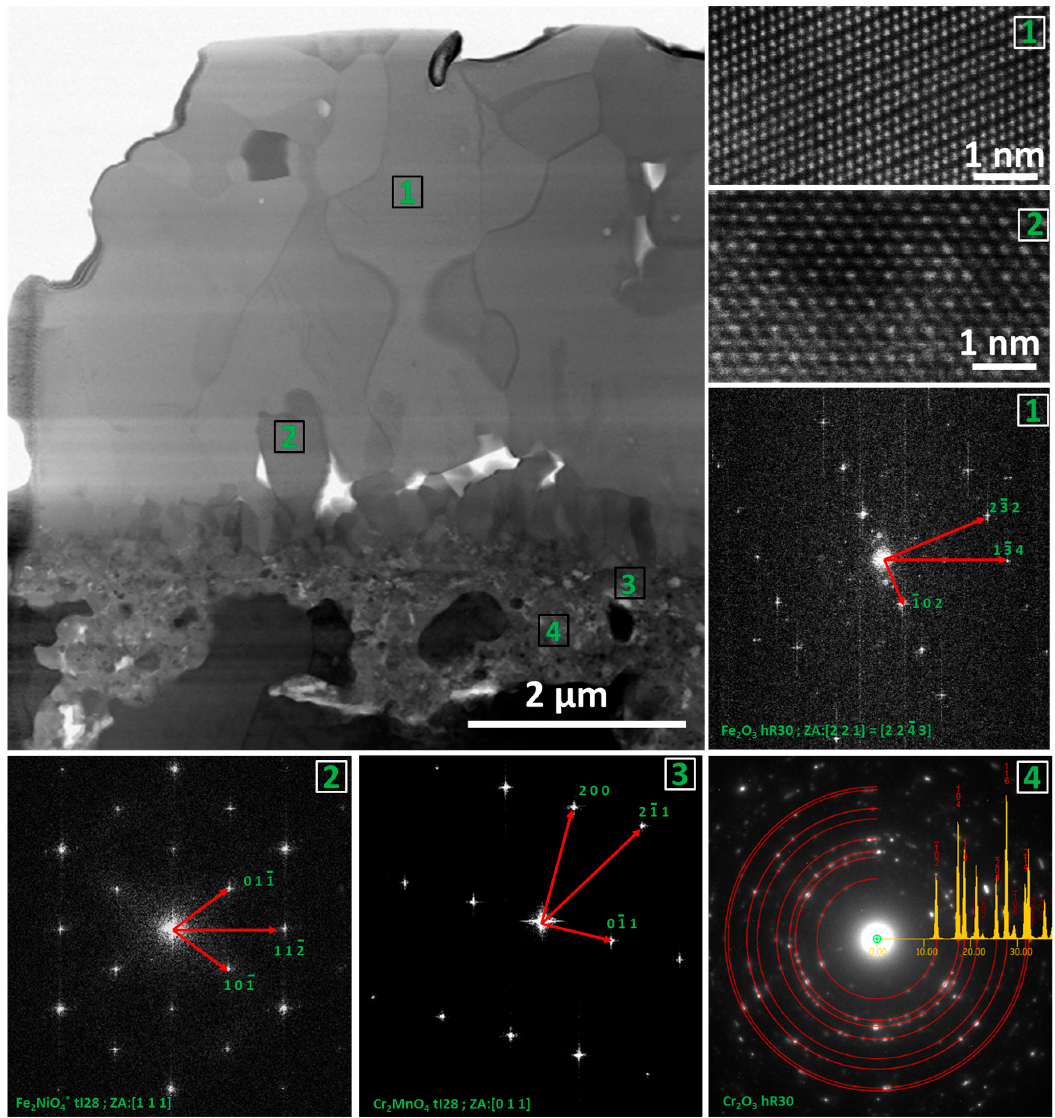
Figure 5. Scanning transmission electron microscopy (STEM) analysis of oxide scale after steam oxidation at 700 ◦ C for 500h. ( a ) STEM-BF (bright field) image of the investigated area, ( b ) high resolution imaging (HR)STEM-HAADF (high-angle annular dark-field) image of area 1 shown in Figure 5a, ( c ) HRSTEM-HAADF image of area 2 shown in Figure 4a, ( d – f ) FFT from area 1, 2, 3, respectively ( g ) selected area electron diffraction (SAED) image of area